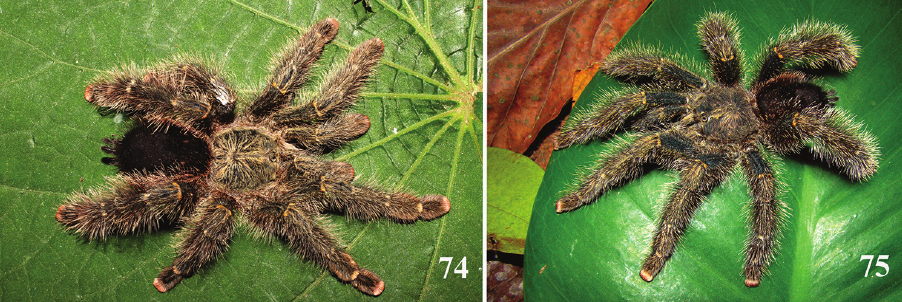
Figures 74–75. Avicularia variegata stat. n., morphotype 2, habitus 74 female 75 male. Photos: 74 C. S. Fukushima; 75 R.